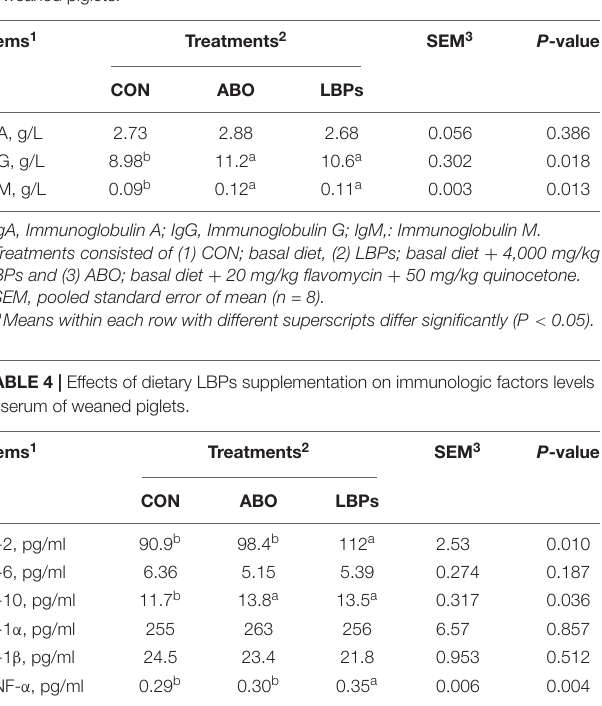
TABLE 3 | Effects of dietary LBPs supplementation on immune response in serum of weaned piglets.